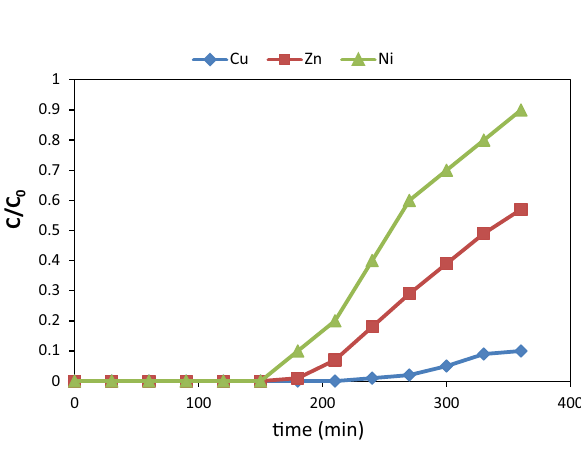
Fig. 5 Breakthrough curve for the adsorption copper, nickel and zinc on VAS-I (flow rate = 0.8 ml/min; T = 27 ± 1 °C)